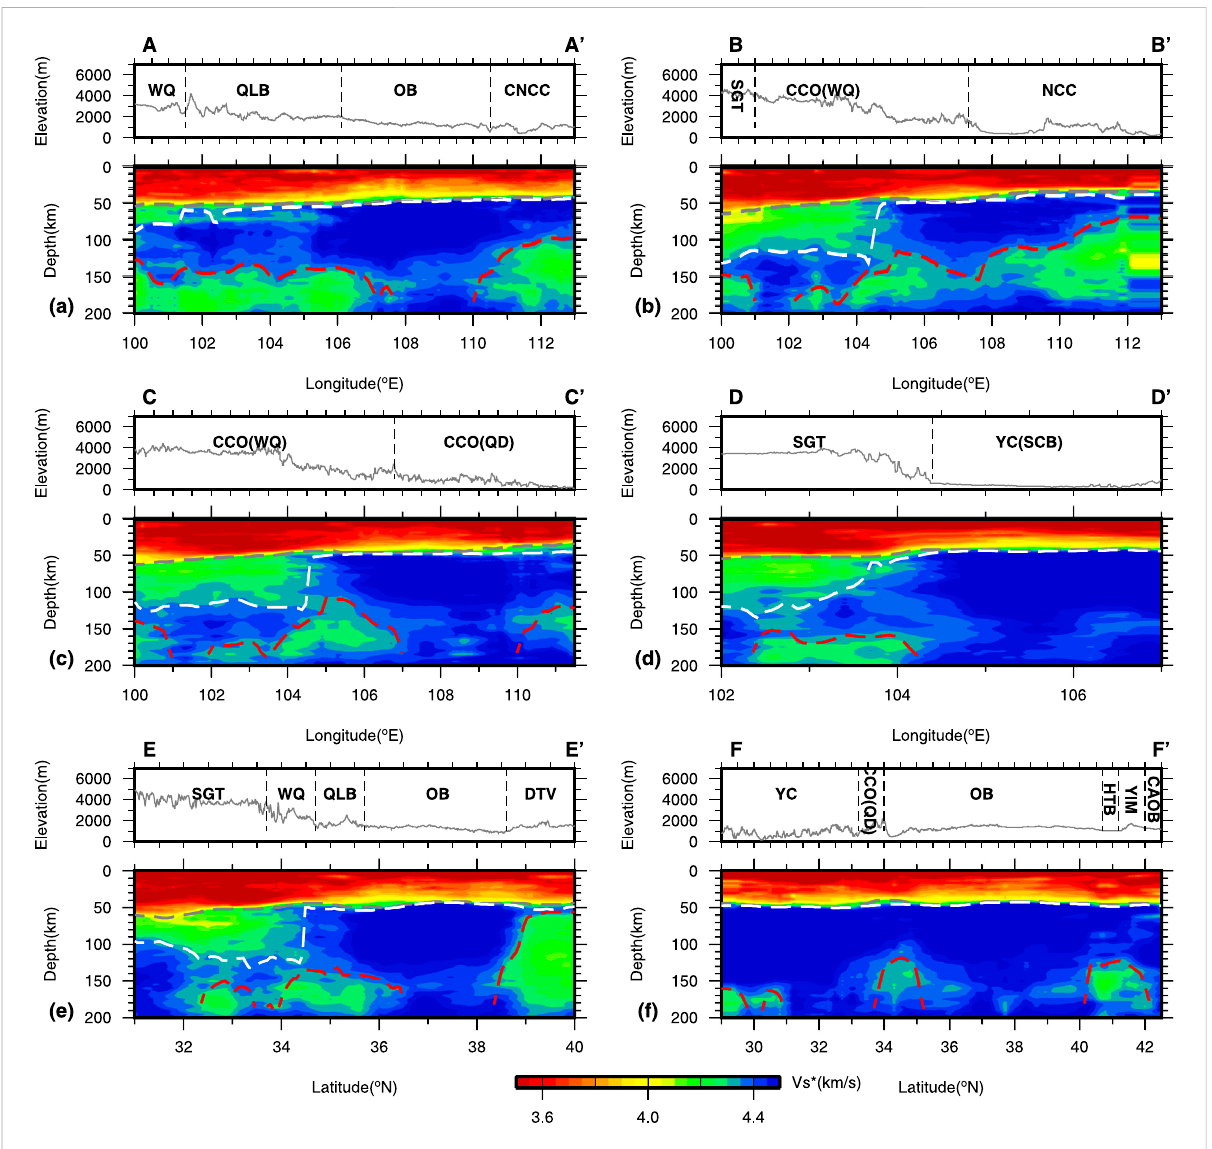
Pressure-corrected S-wave2 velocity structure beneath 6 sections in the study region. (A) AA ’ section; (B) BB ’ section; (C) CC ’ section; (D) DD ’ section; (E) EE ’ section; (F) FF ’ section. The locations of the six sections are shown in Figure 1. The gray, red and white dashed lines represent the depth of Moho, LAB, and the lower boundary of